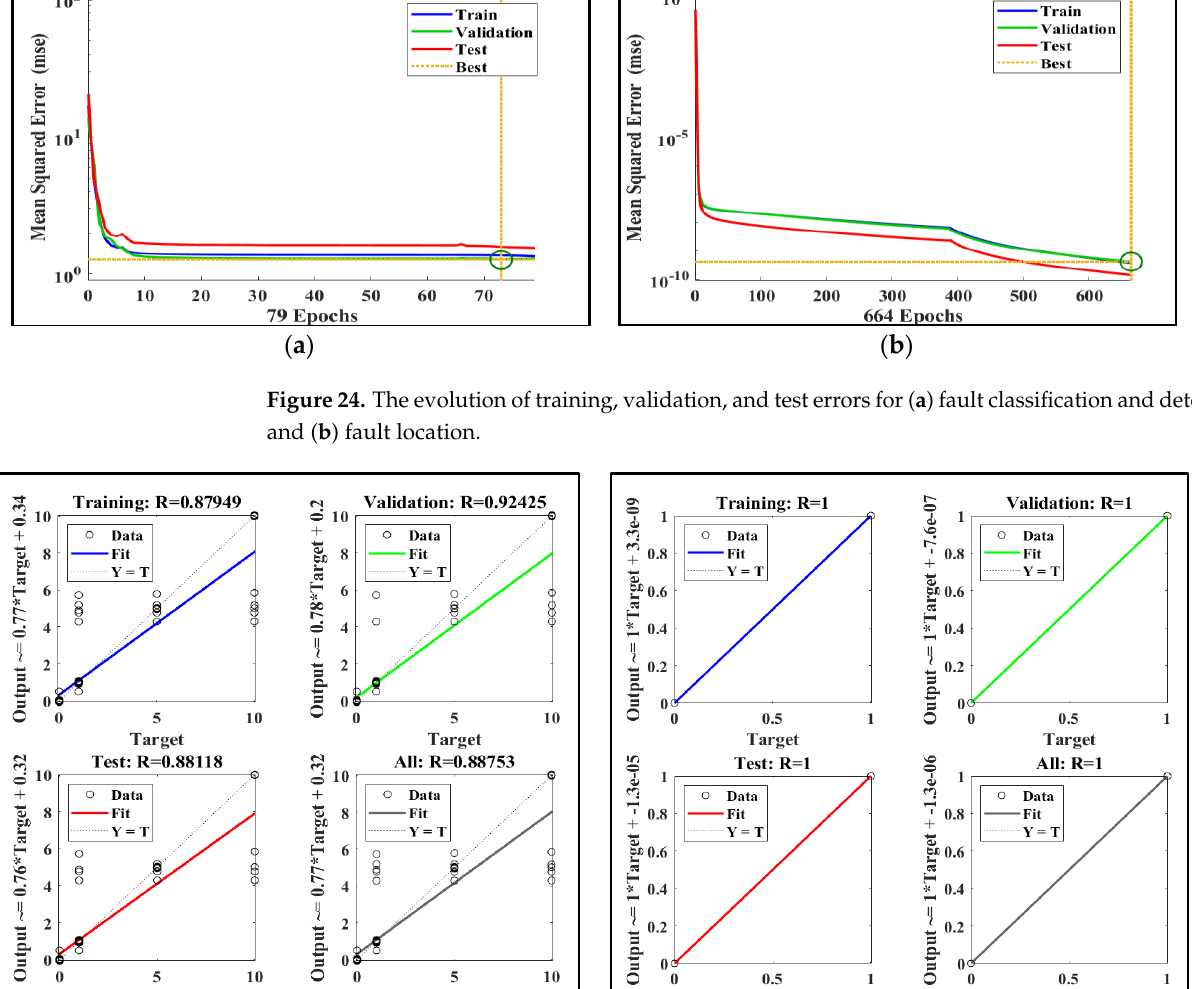
Figure 23. AC bus current and fault location signal .